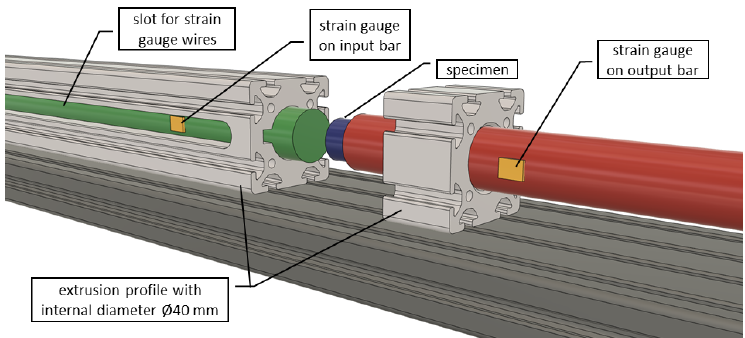
Figure 3: Detail of strain gauge access. The hollow extrusion profile features slots (one on each side) that provide access for the strain gauge wires (not shown